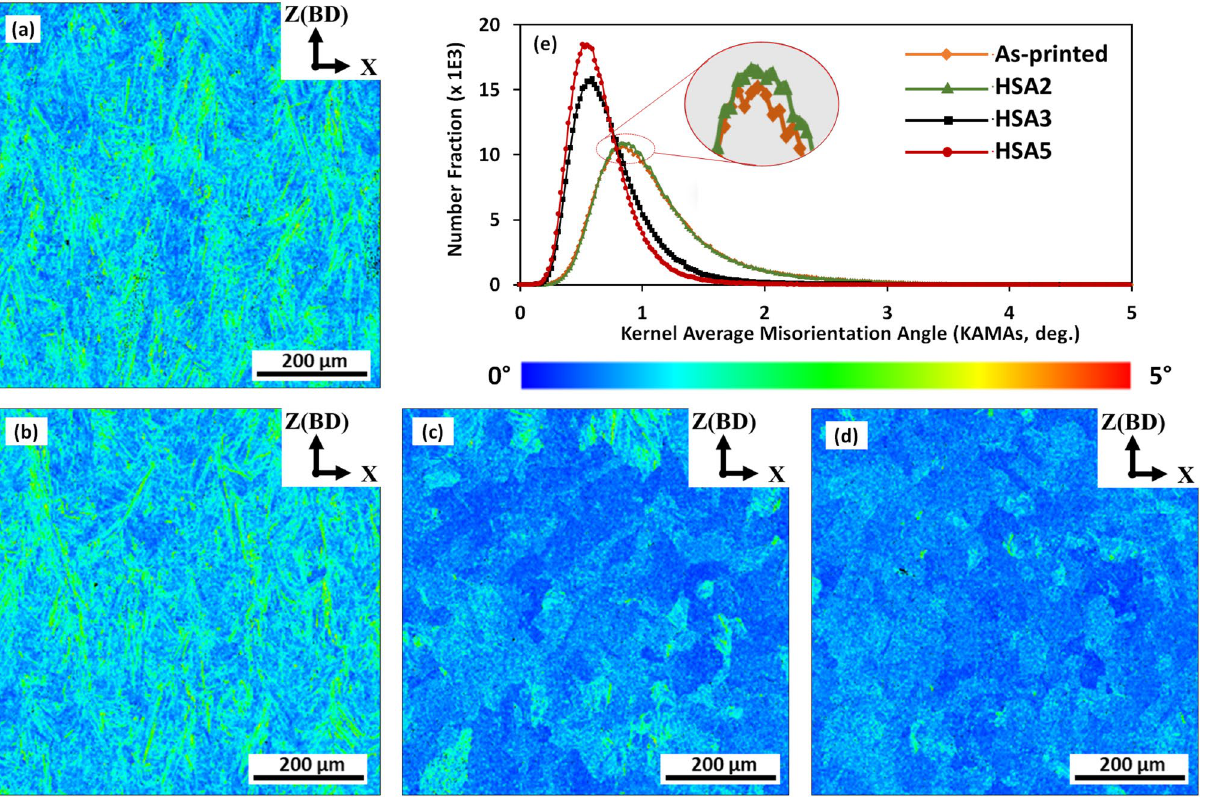
Figure 5. Kernel average misorientation (KAM) maps of the LPBF IN718 in the following conditions: ( a ) as-printed, ( b ) HSA2, ( c ) HSA3, ( d ) HSA5 and number fraction of KAM under as-printed and aforementioned heat treatment